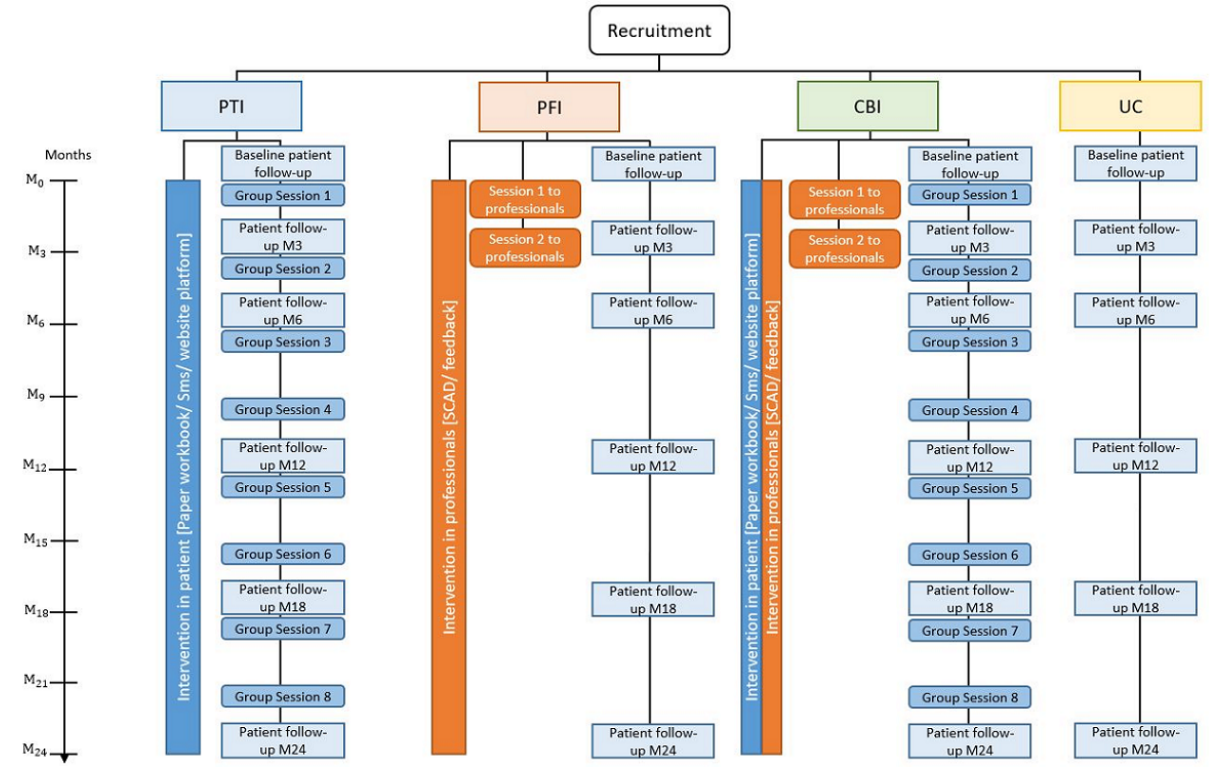
Figure 1. Arm’s intervention timeline and follow-up